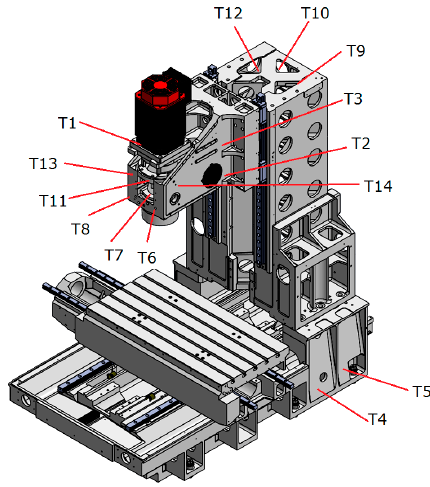
Figure 4. Schematics of the initial measurement of temperature fields with 14 sensors.